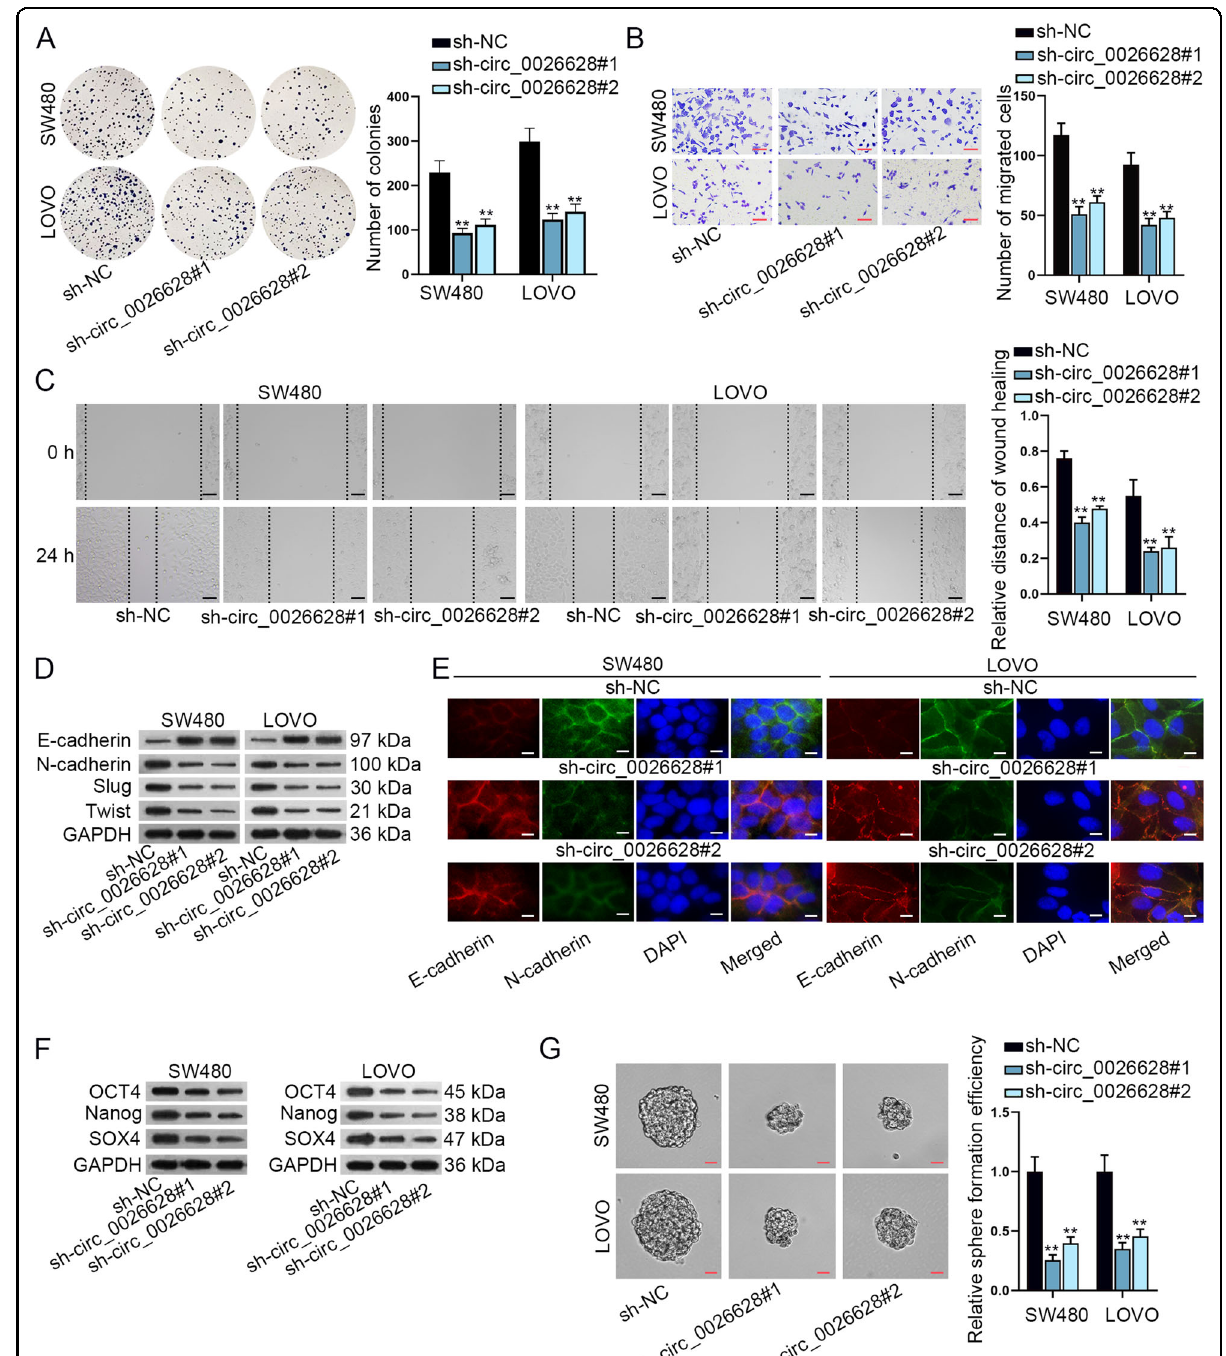
Fig. 2 Circ_0026628 promoted CRC cell proliferation, migration, EMT, and stemness. A Colony formation assay examined the in fl uence of silenced circ_0026628 on the proliferation ability of CRC cells. One-way ANOVA. B , C Transwell (scale bar: 180 μ m) and wound-healing assays (scale bar: 120 μ m) revealed the migration ability of circ_0026628 silenced cells. One-way ANOVA. D Western blot determined the levels of EMT biomarkers including E-cadherin, N-cadherin, Slug, and Twist in circ_0026628 silenced cells. E IF staining assay (scale bar: 150 μ m) analyzed the effects of silenced circ_0026628 on the positivity of E-cadherin and N-cadherin in CRC cells. F Western blot explored the expression of stemness biomarkers (OCT4, Nanog, and SOX4) in circ_0026628 silenced cells. G Sphere formation assay (scale bar: 150 μ m) detected the sphere formation ef fi ciency of circ_0026628 silenced cells. One-way ANOVA. ** P <